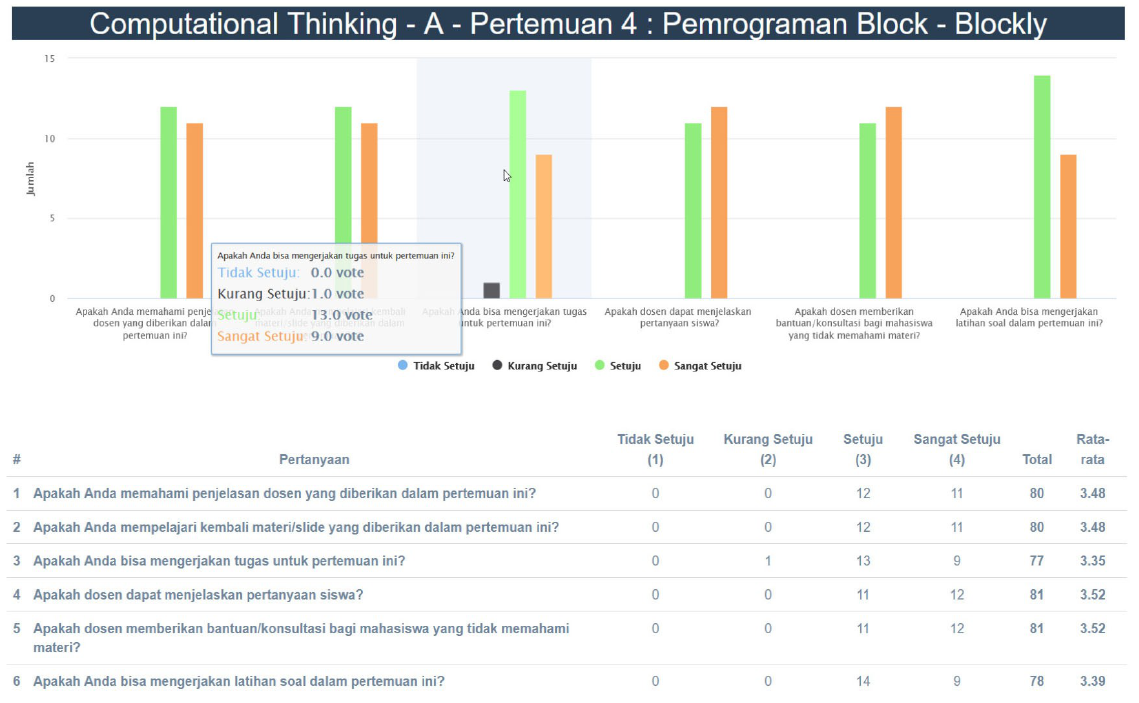
Figure 4. An example of interactions in course rating. Students can give opinions about a session and lecturers can view the opinions in a bar